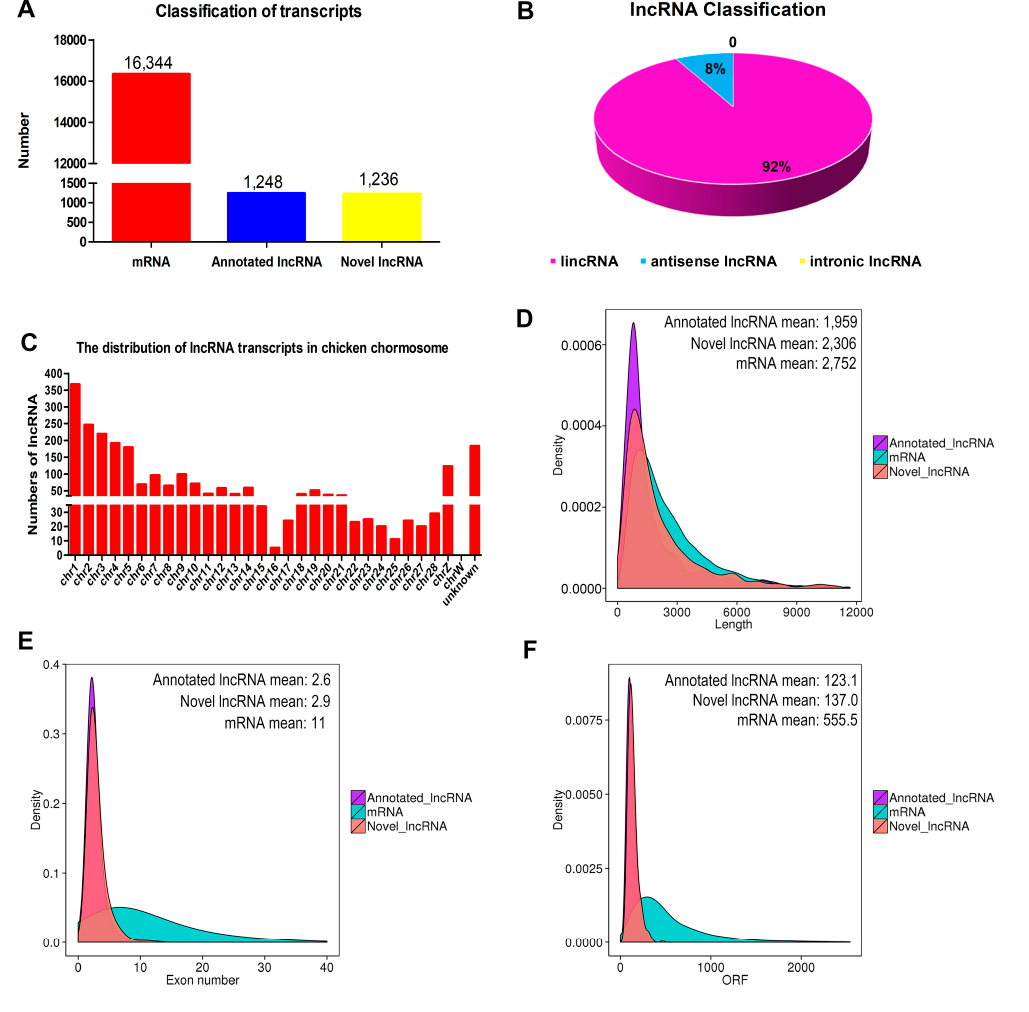
Figure 2. Characterization analysis of long non-coding RNAs (lncRNAs). ( A ) The classification of transcripts by RNA sequencing (RNA-seq); ( B ) lncRNA classification; ( C ) chromosome distribution of lncRNA transcripts in chicken primary myoblasts; ( D ) the length comparative analysis of lncRNAs and messenger RNA (mRNAs); ( E ) the exon number distribution of lncRNAs and mRNAs; and ( F ) the distribution of the open reading frame (ORF) length of lncRNAs and mRNAs.